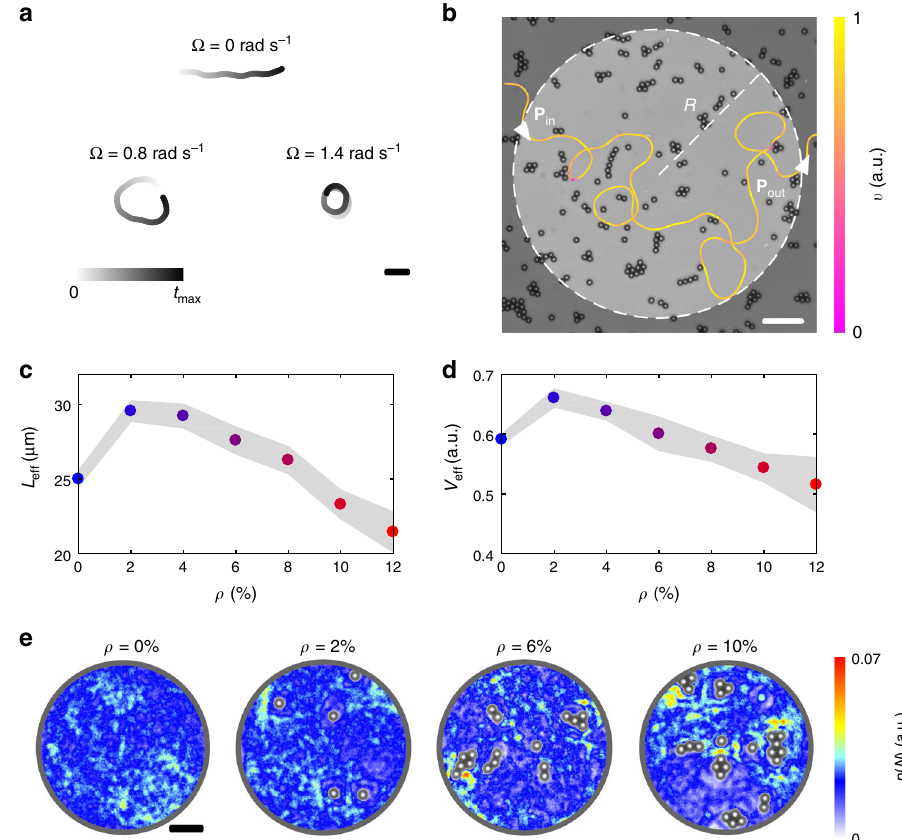
Fig. 1 Propagation and localisation of E. coli cells near surfaces with micro-obstacles. a Exemplary 10-s-long trajectories of E. coli cells swimming near a